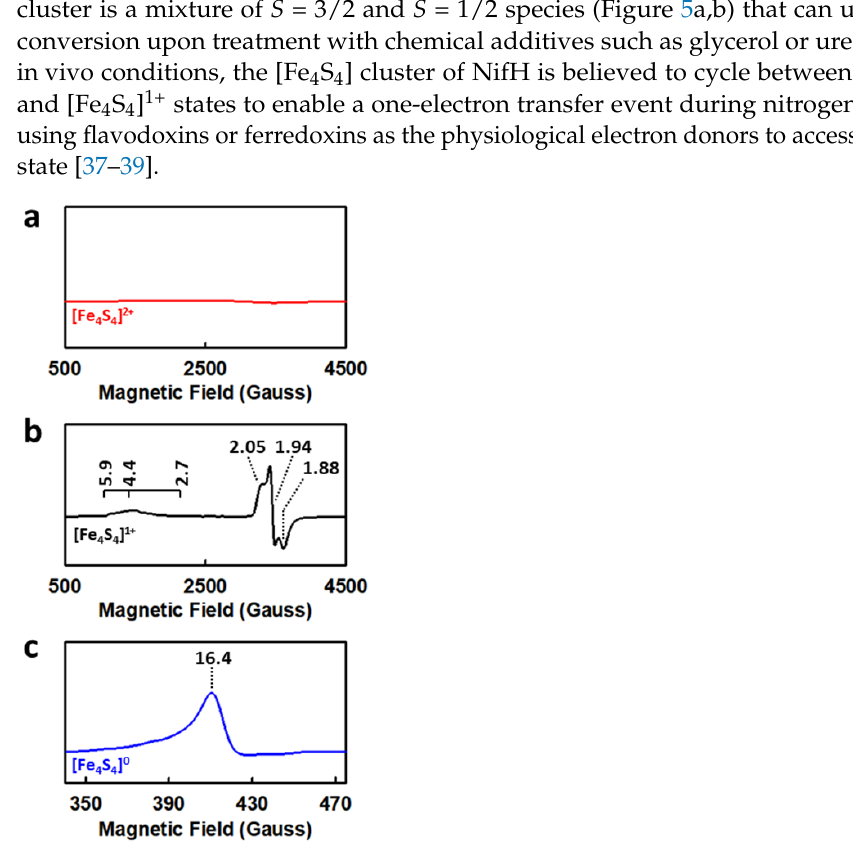
Figure 5. The three oxidation states of NifH. Shown are the perpendicular-mode EPR spectra of ( a ) the oxidized, [Fe 4 S 4 ] 2+ state and ( b ) the reduced, [Fe 4 S 4 ] 1+ state of NifH; and ( c ) the parallel-mode EPR spectrum of the super-reduced, all-ferrous [Fe 4 S 4 ] 0 state of NifH. The g values are indicated. Such an interconversion between the [Fe 4 S 4 ] 2+ and [Fe 4 S 4 ] 1+ states of NifH, depicted as